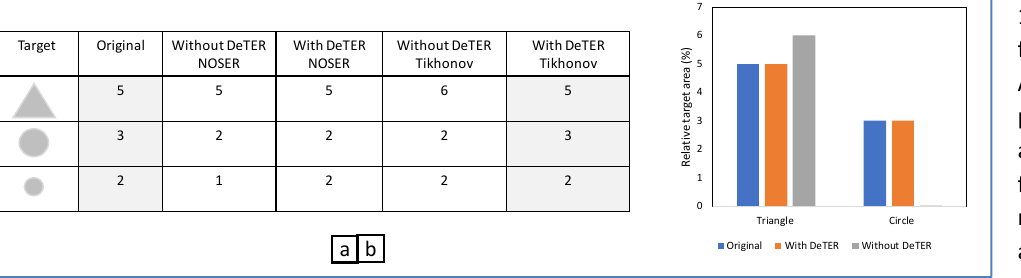
Fig.12: (a) Relative target area (%) for all targets in the original and reconstructed images